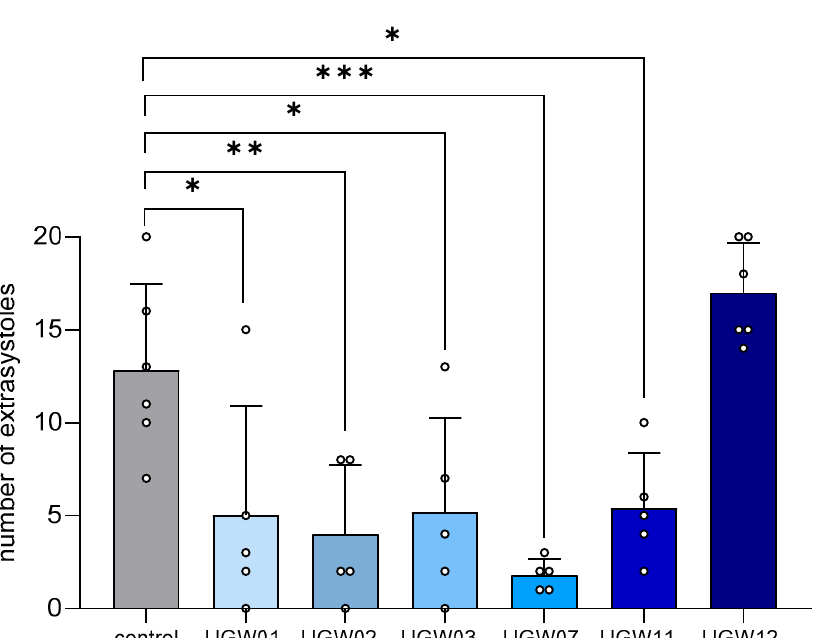
Figure 1. The therapeutic antiarrhythmic activity of the studied compounds in the adrenaline-induced arrhythmia model in rats. After an intravenous ( iv ) injection of adrenaline (20 µ g/kg), the tested compounds were immediately administered iv . The control group received no additional treatment. The electrocardiogram (ECG) was recorded for the first 2 min and then at the 5th, 10th, and 15th min of the experiment. The criterion of antiarrhythmic activity was the decrease in or complete absence of extrasystoles in the ECG recording compared with the control group. The results are presented as means ± SD for active or maximum tested doses (1 mg/kg for JJGW01, JJGW07, and JJGW11, and 5 mg/kg for JJGW02, JJGW03, and JJGW12). Statistical analysis: one-way ANOVA (Dunnett’s post hoc ); * p < 0.05, ** p < 0.01, *** p < 0.001; n = 5–6 rats.